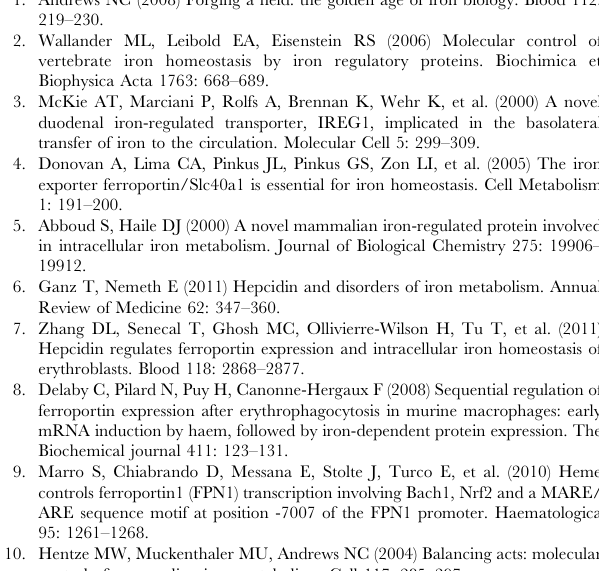
Figure S3 (A) Western blot confirmation of antibody specificity by silencing of FPN with siRNAs. HepG2 lysate from cells transfected with control or FPN-targeting siRNAs were analyzed by PAGE and probed with FPN antibody. One indicated , 68 KDa band was recognized as FPN protein by its reduction in intensity following the silencing of FPN. (B) Western blot analysis of FPN in K562 cells transfected with miR-485 (pc-miR- 485) or vector control (pc-vector), normalized to tubulin levels. (C) Ferritin protein levels from corresponding samples in Figure S3A as measured by ferritin ELISA. Data are the mean 6 SEM (n =3). (D) QRT-PCR analysis of miR-485-3p expression in K562 cells